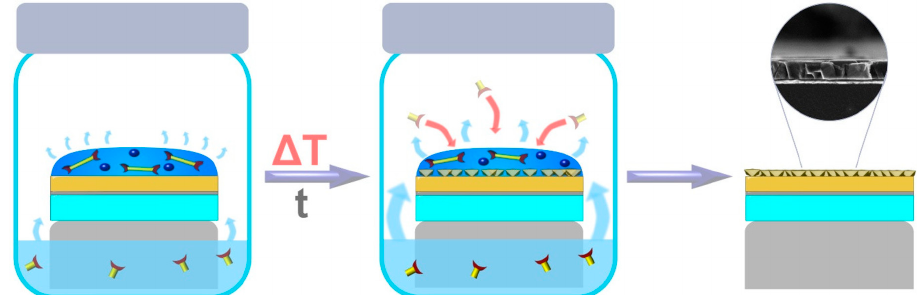
Figure 14. Schematic representation of the vapor-assisted conversion process for the fabrication of oriented MOF films (adapted with permission from ref [97].